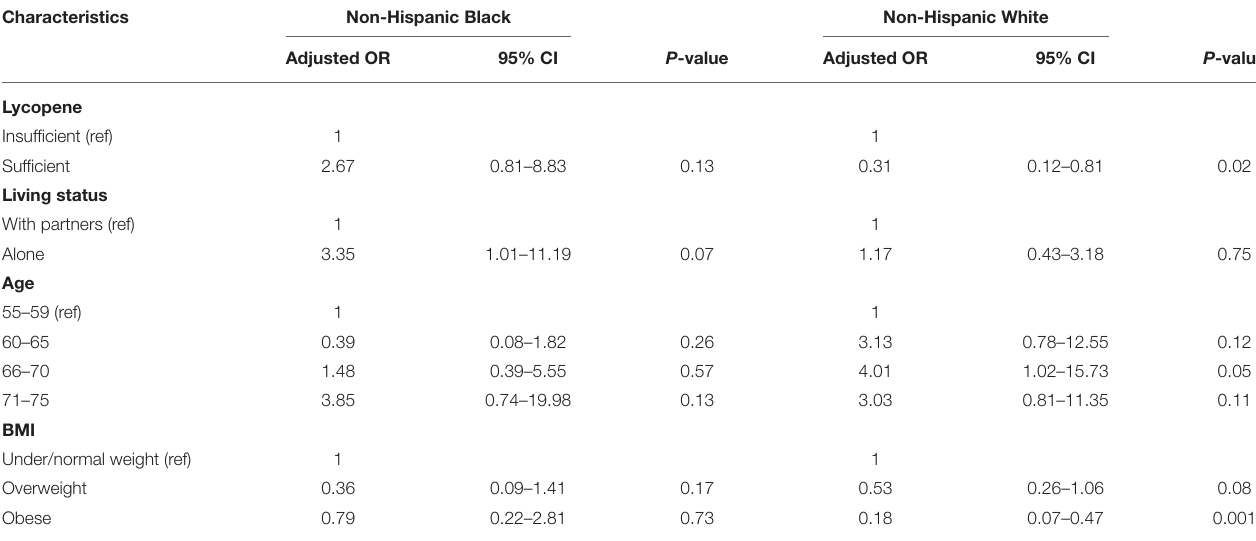
TABLE 3 | Factors associated with a high risk of PCa across different race groups.